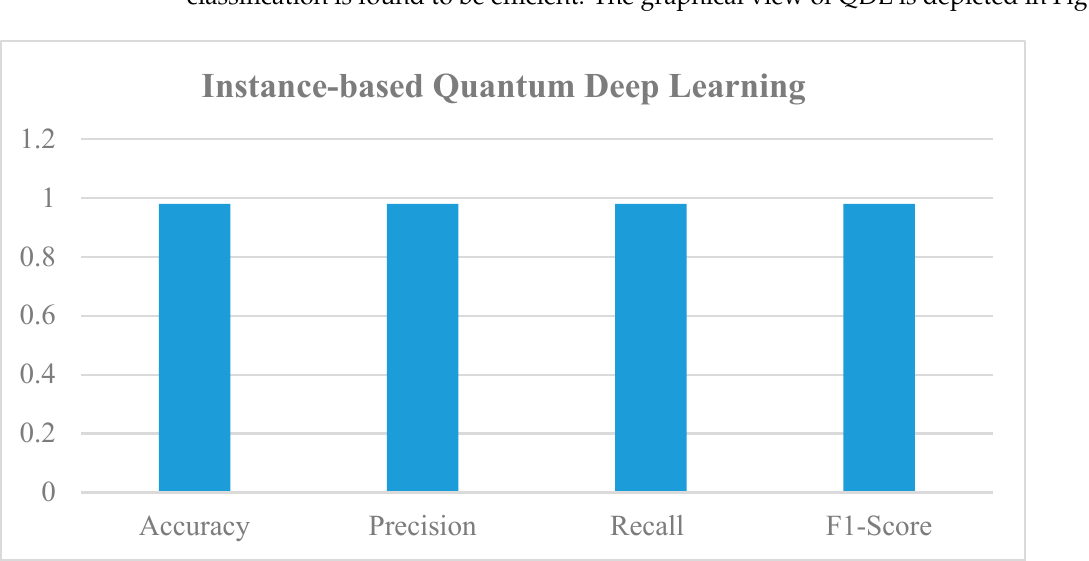
Table 6. QNN based on Qubit analysis with accuracy.